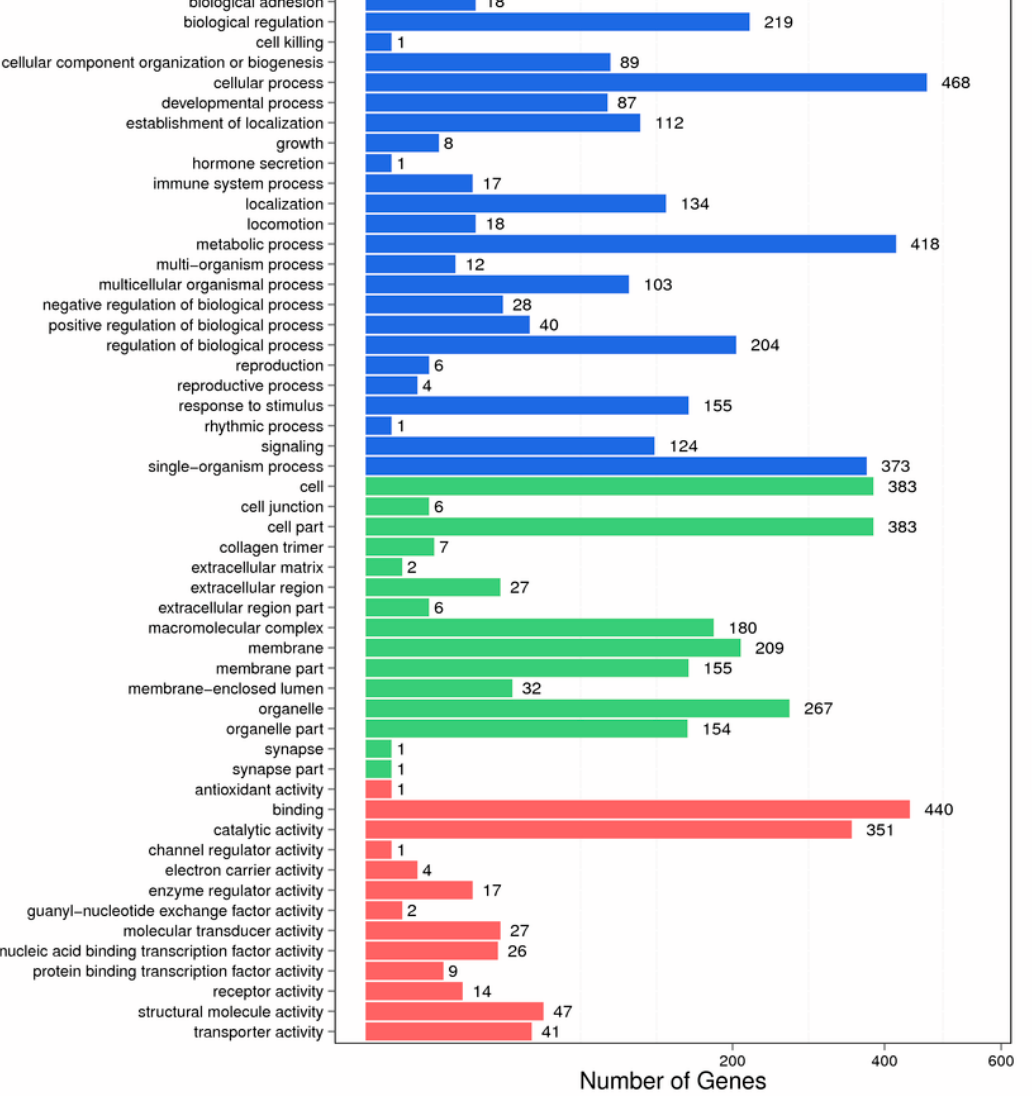
Figure 2. Functional distribution of GO annotation.